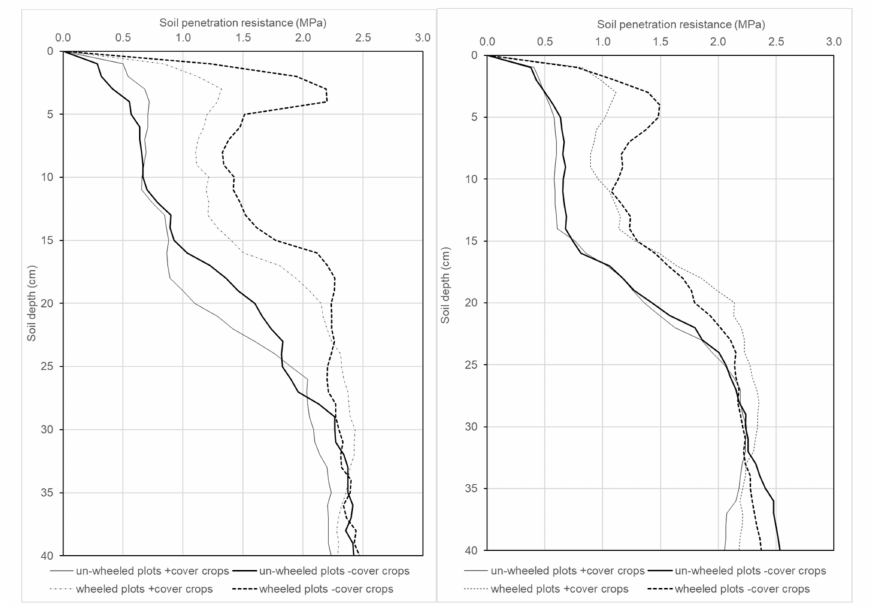
Figure 2. Soil penetration resistance (MPa) at high tire inflation pressure ( left ) and low tire inflation pressure ( right ), comparing un-wheeled plots and wheeled plots; +cover crop and − cover crop. Wheeled plots were over-rolled with the tractor-filled slurry